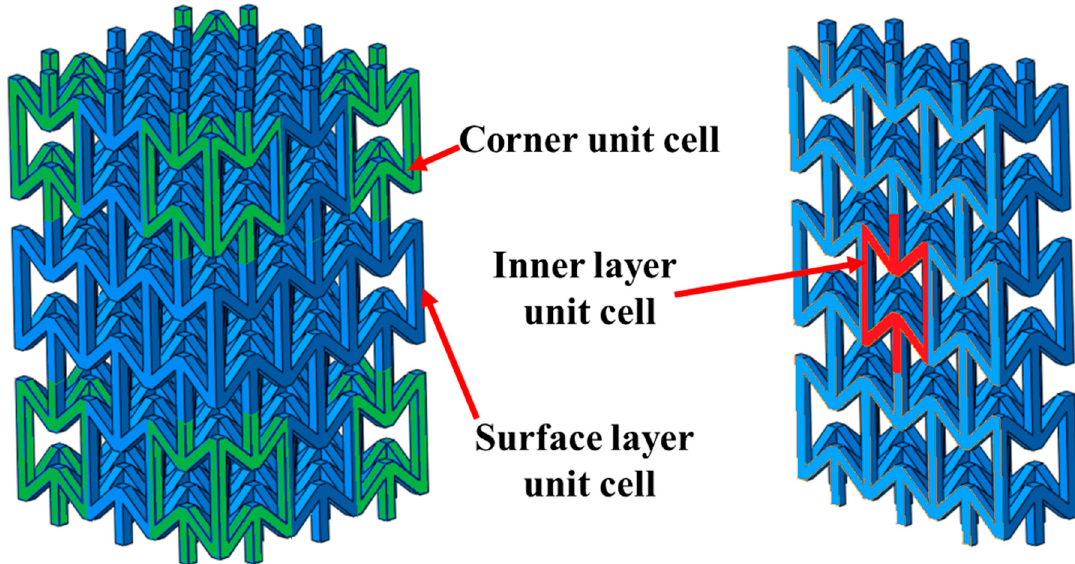
Figure 9. Structure size effect in 3D auxetic structure.